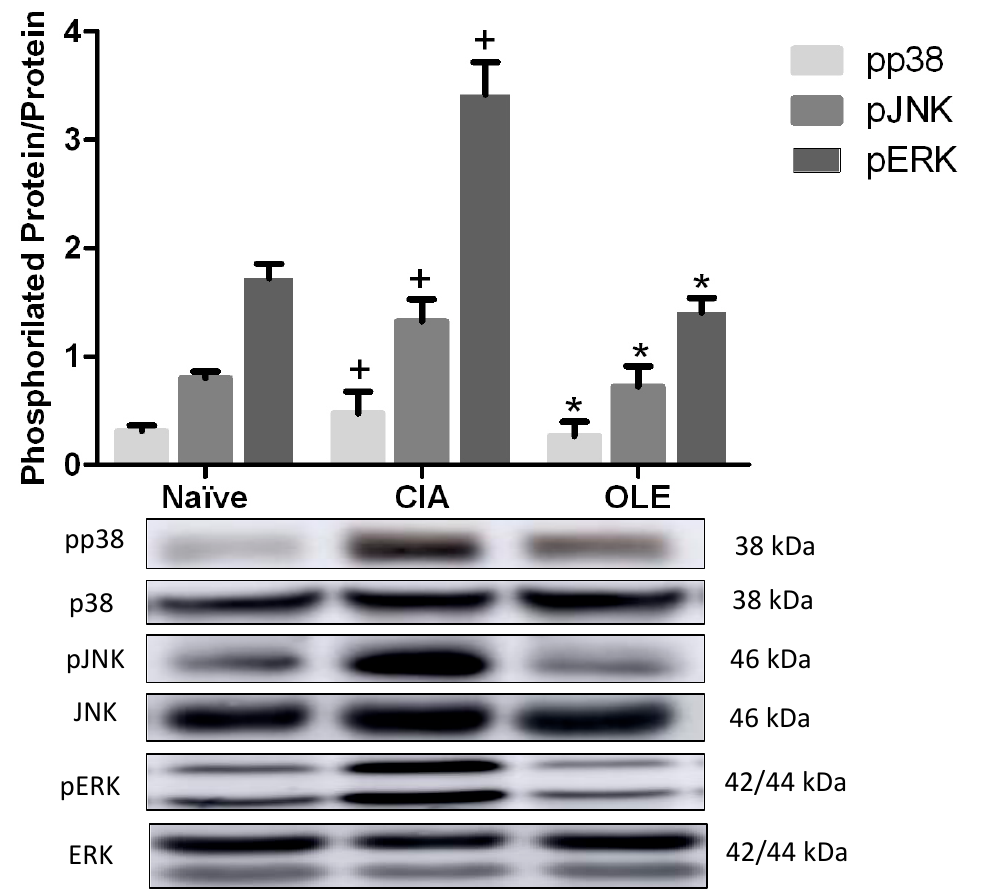
Figure 9. OLE diet modulated MAPKs signaling pathways in hind paws homogenates. Phosphorylated p38, JNK and ERK was analyzed with Western blot and normalized with respect to specific non-phosphorylated total proteins. Western blot images are representative of separate experiments with similar results. Naïve group, non-arthritic control animals fed with SD; CIA, control group induced arthritic animals fed with SD; OLE induced arthritic animals fed with OLE enriched diet (0.025% w/w ). Values represented mean ± S.E.M. ( n = 8), + p < 0.05 vs. Naïve non-arthritic group; * p < 0.05 vs. CIA arthritic